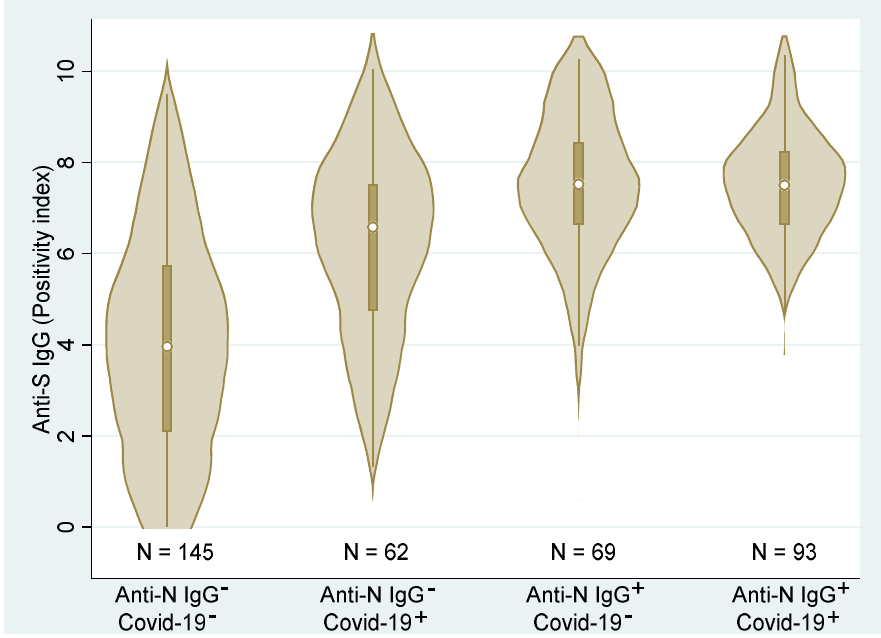
Figure 4. Distributions and box plots of anti−S IgG levels according to the personal COVID−19 history status based on medical records (COVID−19 −/+ ) and anti−N IgG (Anti−N IgG −/+ ) (N—number of observations).